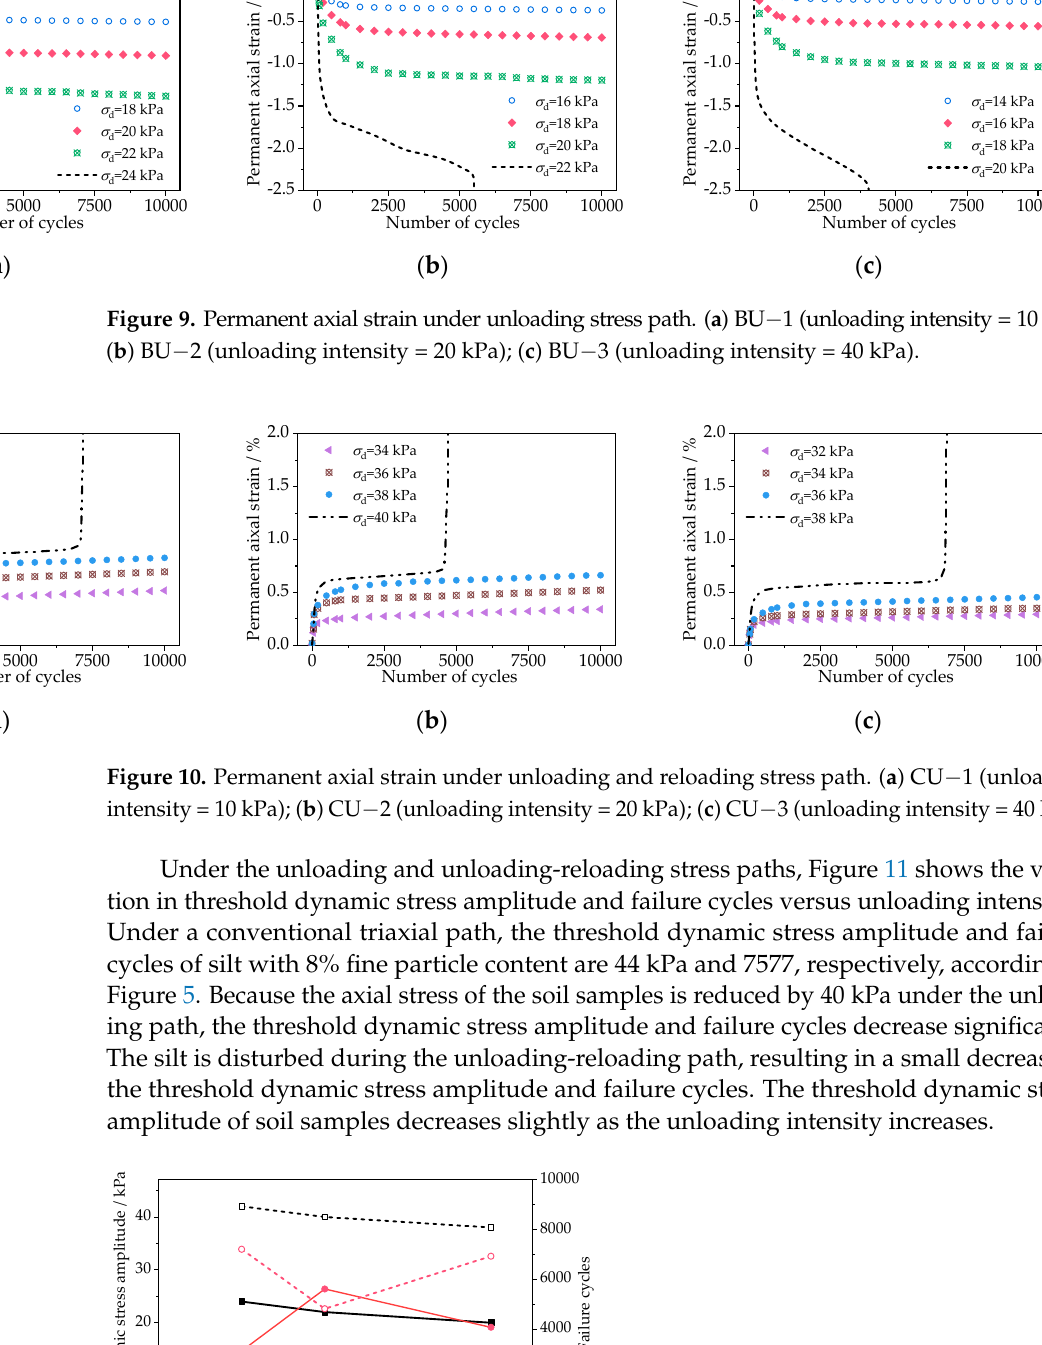
Figure 11. Threshold dynamic stress amplitude and failure cycles under different stress paths.